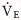
Cross validation results for Model D1: V˙E = e-9.59HR2.39age0.274sex-0.204FVC0.520, where HR is beats per minute, age is in years, FVC is the GLI predicted value expressed in liters, and sex is 1 for males and 2 for females.The median(IQR) percent error from cross-validation for this model is -0.664(45.4)%. Circles are persons without an FVC measurement; triangles are persons with measured FVC = 85–115% of the predicted value; diamonds are persons with measured FVC < 85% predicted, and squares are persons with measured FVC > 115% predicted. Dashed lines are ±25% error.